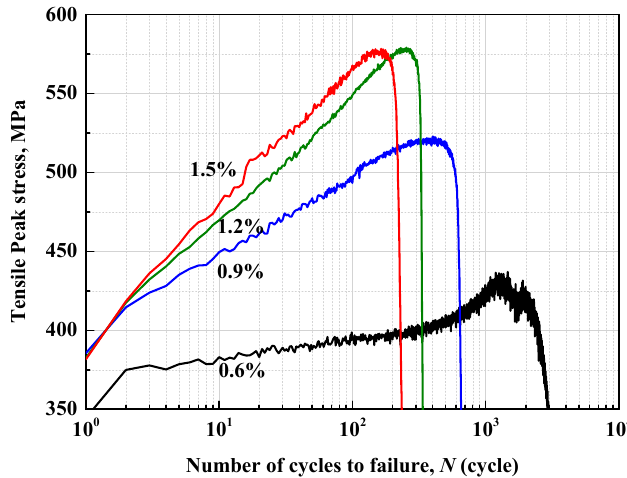
Figure 6. The serrated flows in the tensile peak stress curves of Alloy 617 weldments at 800 °C.